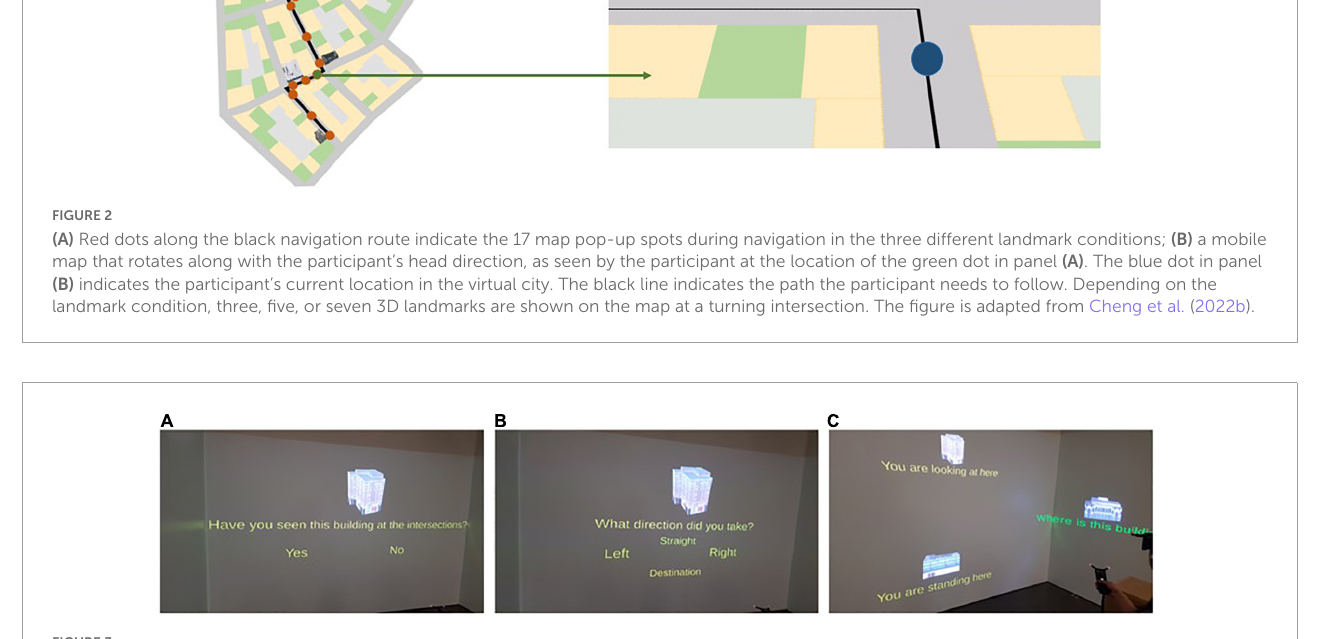
FIGURE3 The three panels depict how participants responded to the spatial learning tests in the CAVE using a 3D pointing device after navigation: (A) The landmark recognition test, (B) the route direction test, and (C) the JRD test, respectively. The figure is adapted from Cheng et al. (2022b).